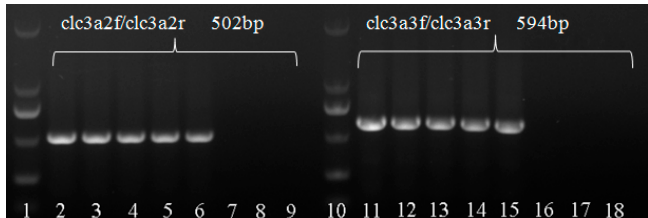
Figure 6. Amplification with primer clc3a2f/clc3a2r and primer clc3a3f/clc3a3r. Lanes 1 and 10: Marker DM2000; lanes 2–6: Amplification from uredinia of the five specimens of M. medusae (HMAS 247969-71, HMAS 247972-73) using primers clc3a2f/clc3a2r; Lanes 11–15: Amplification from uredinia